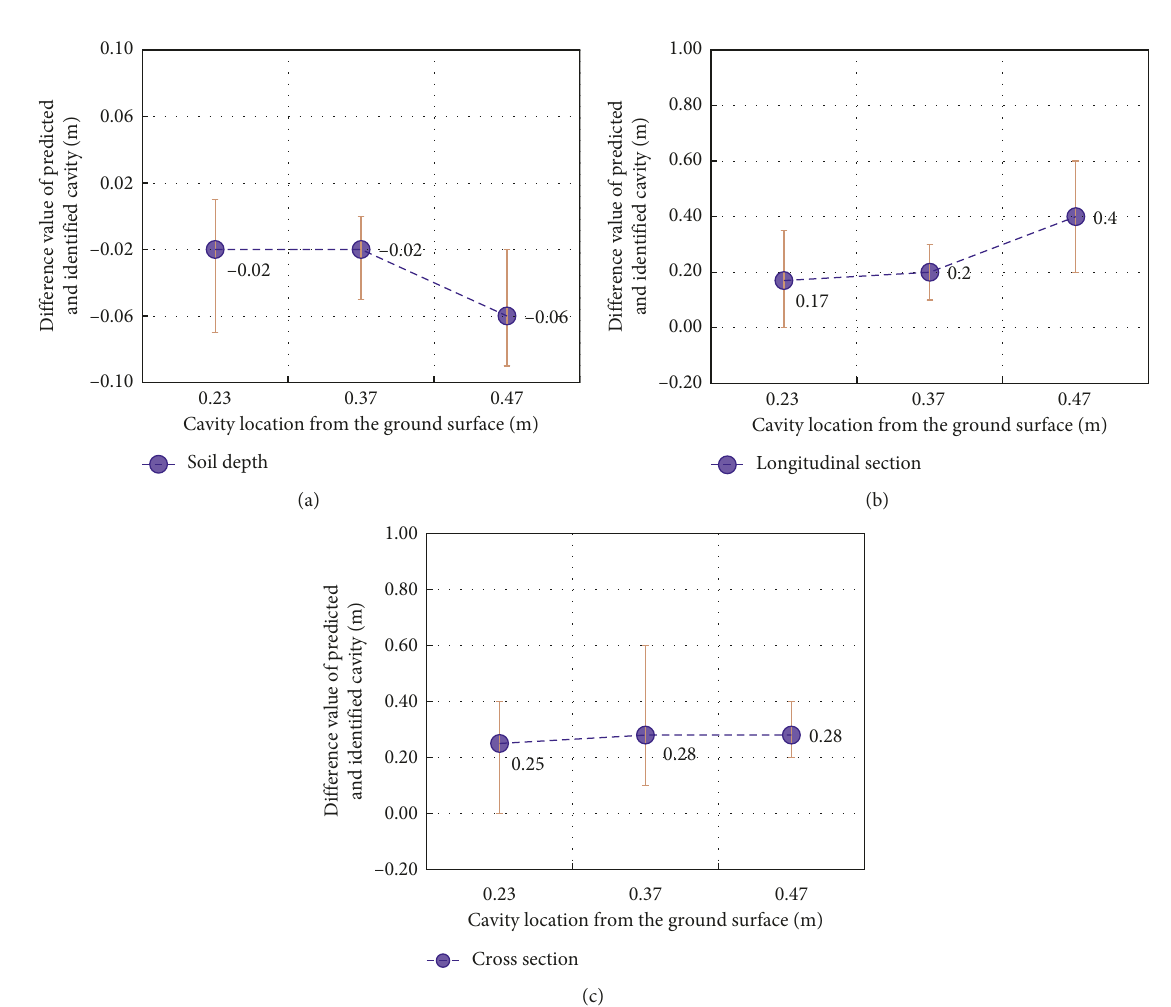
Figure 8: Difference between the predicted cavity scale and the identified cavity scale according to the location of the cavity. (a) Soil depth. (b) Longitudinal section. (c) Cross